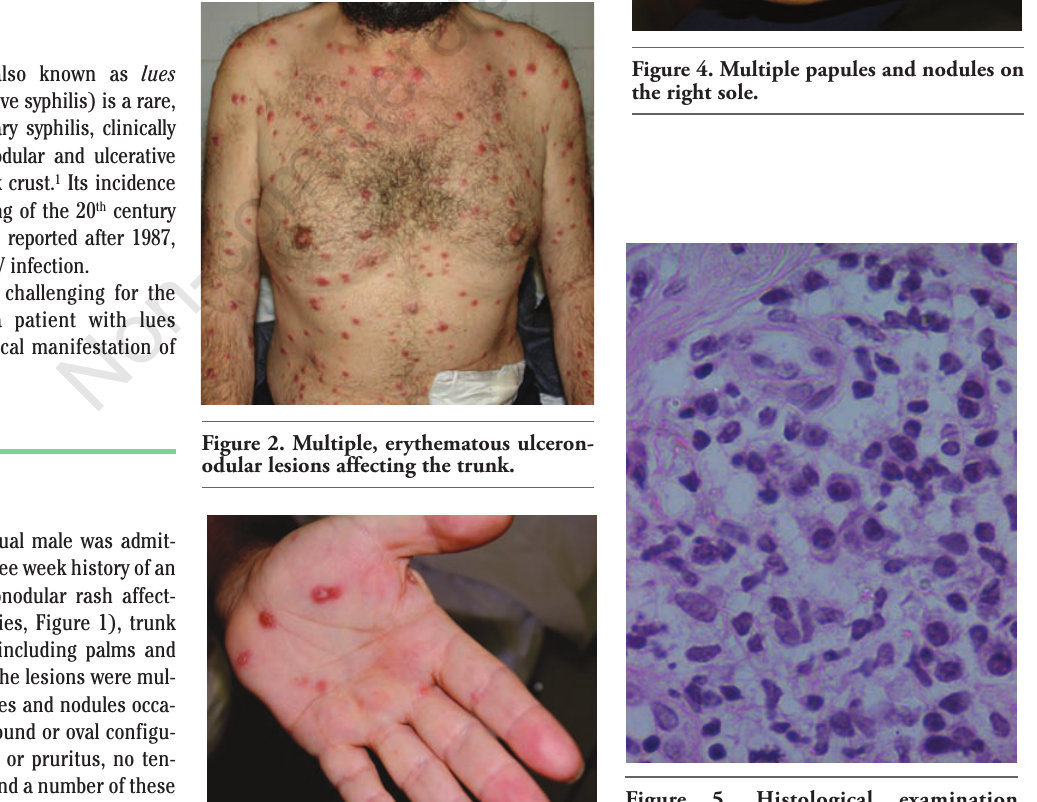
Figure 5. Histological examination revealed perivascular dermal infiltrate composed of many plasma cells (hema- toxylin and eosin stain, magnification ¥